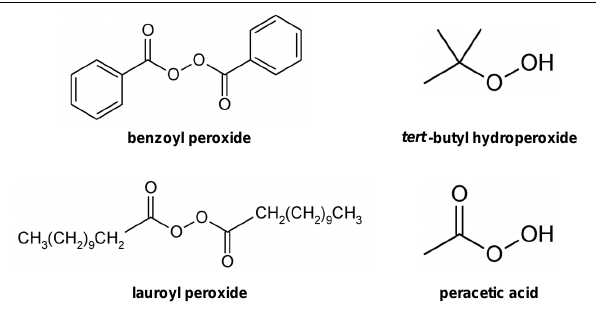
Table 1. Organic peroxides used in this study.